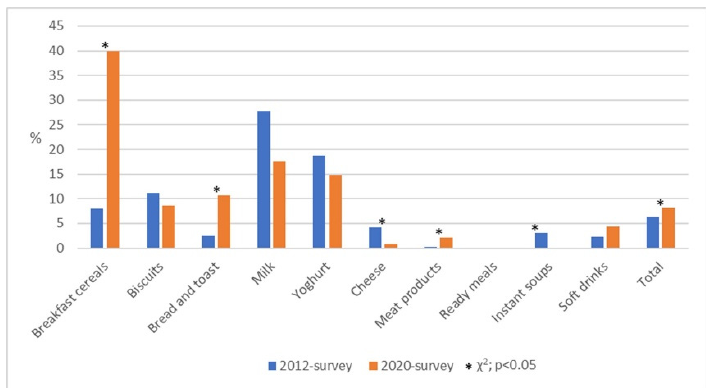
Figure 4. The proportion of pre-packaged food products containing health claims in the 2012 survey [15] and the 2020 survey by product category. % is calculated over the total of products within each food group; * marks statistically significant difference between proportions in the 2012 survey and the 2020 survey, Chi-square test, p < 0.05.